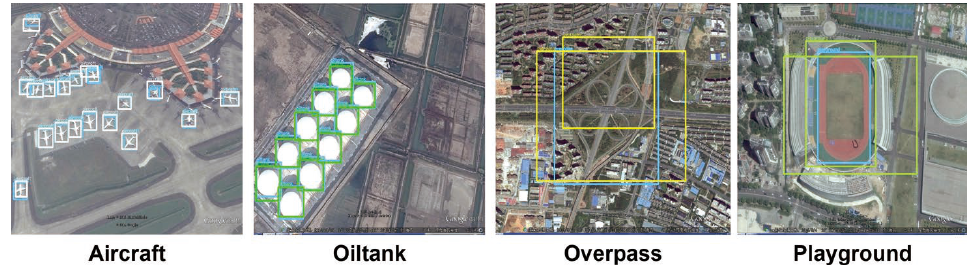
Figure 1. Demonstration of complicated remote sensing scenes in RSOD dataset. The detected bounding box are draw by using